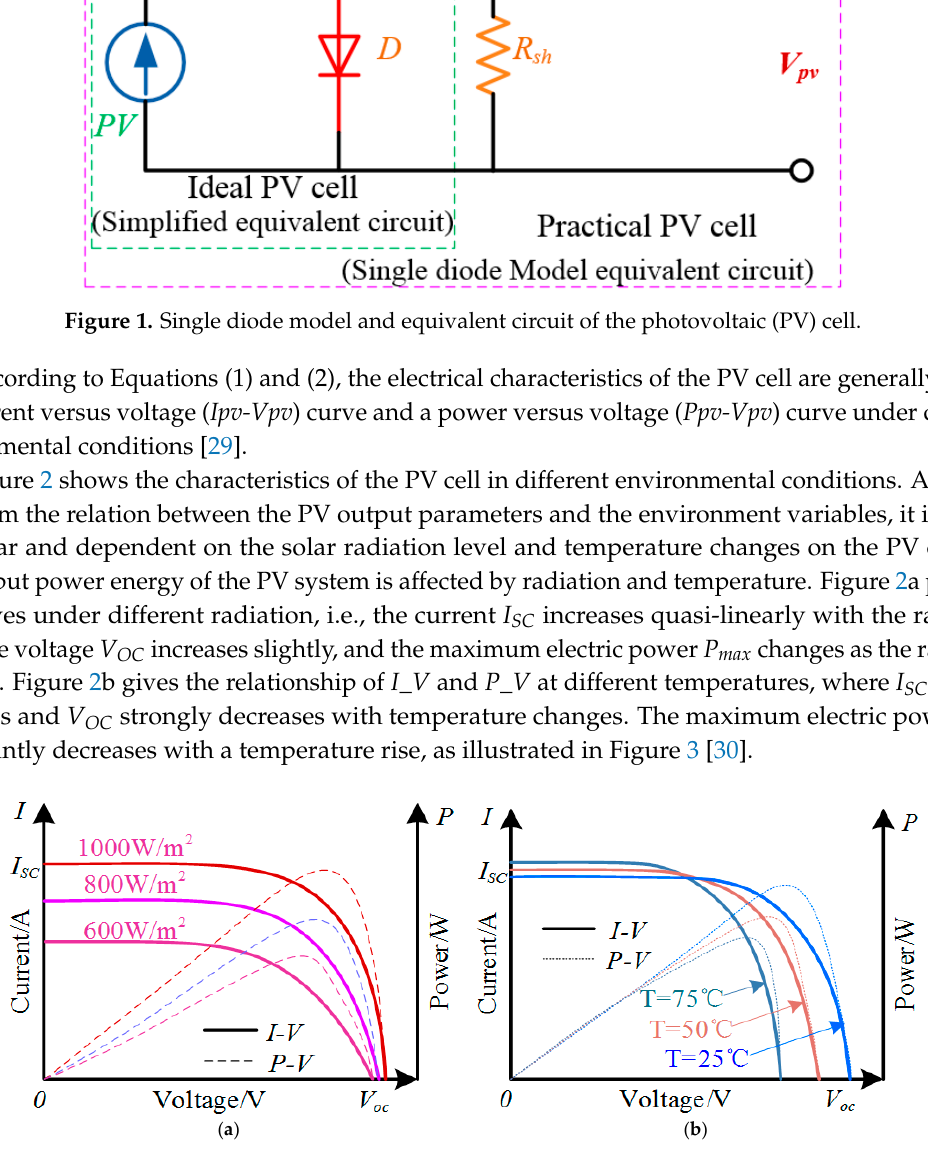
Figure 2. Characteristics of the PV cell at different environmental conditions: ( a ) Different solar radiation level effect; ( b ) different temperature variability